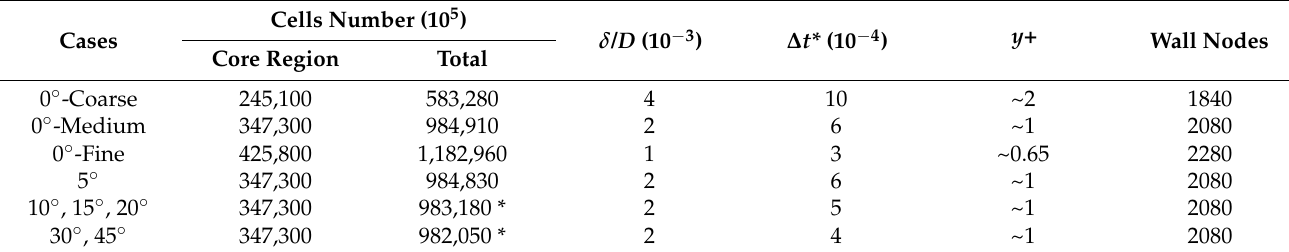
Table 1. The characteristics of computational grids for different